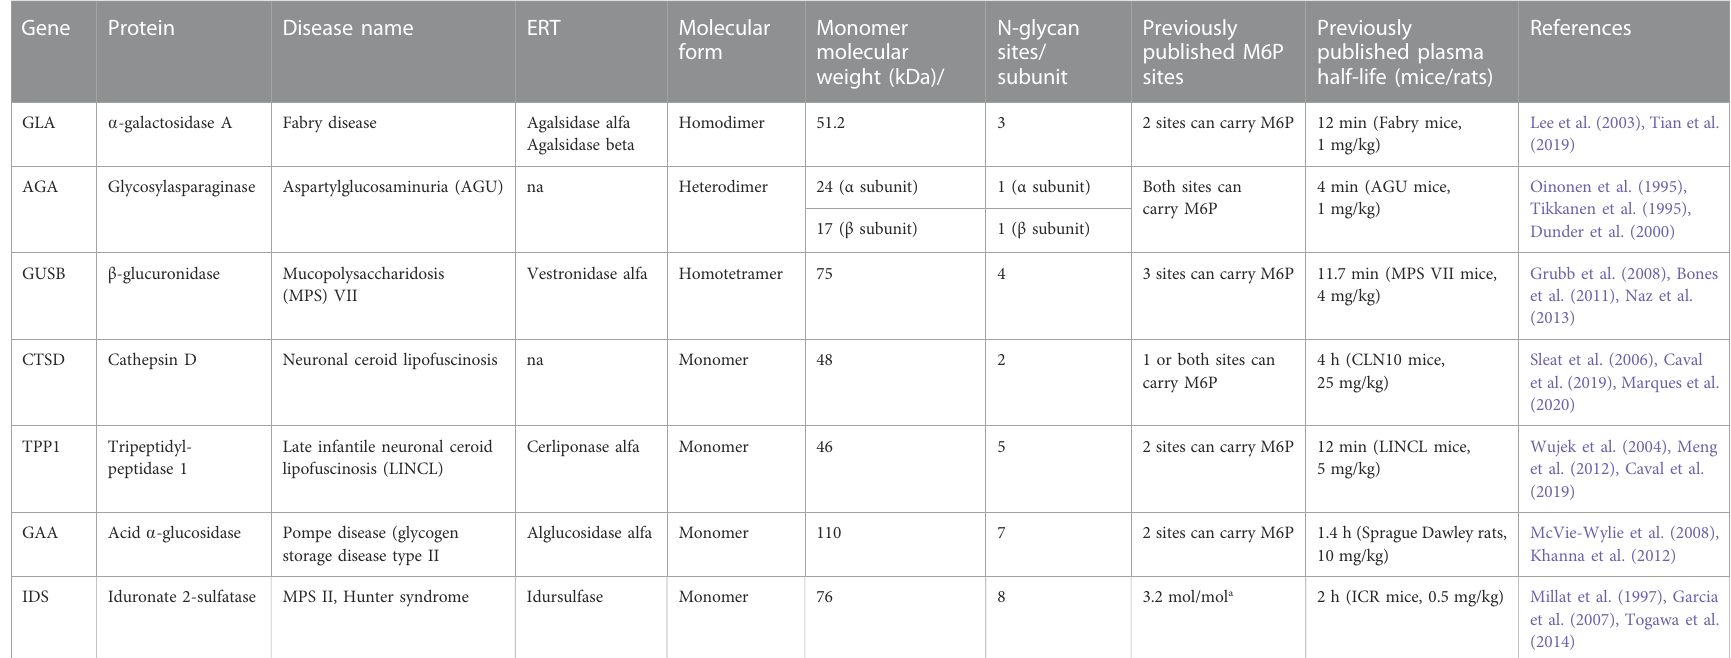
TABLE 1 List of lysosomal enzymes included in the